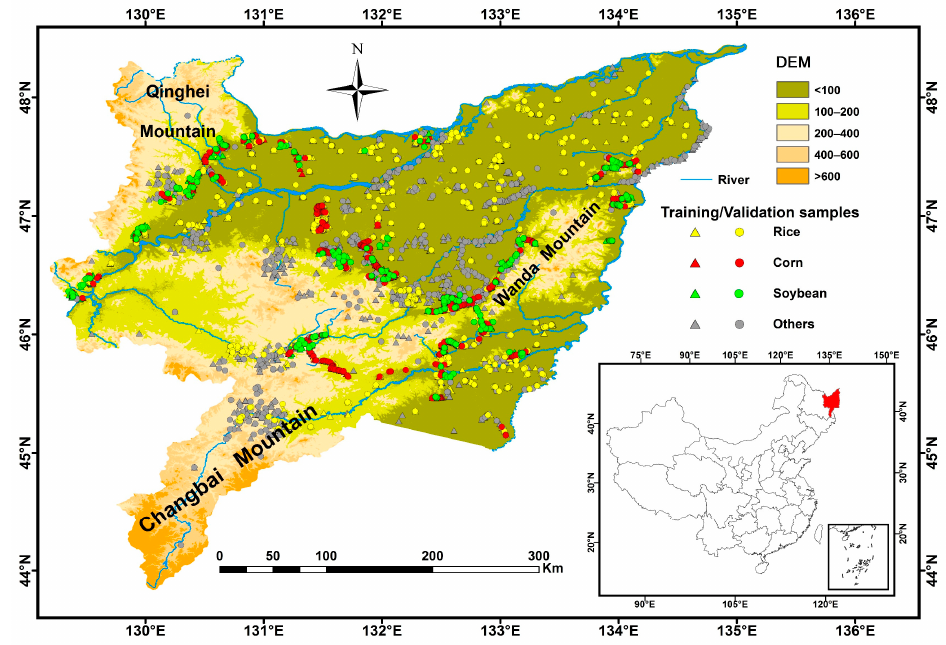
Figure 1. The location of the study area and distribution of the ground truth sampling data.